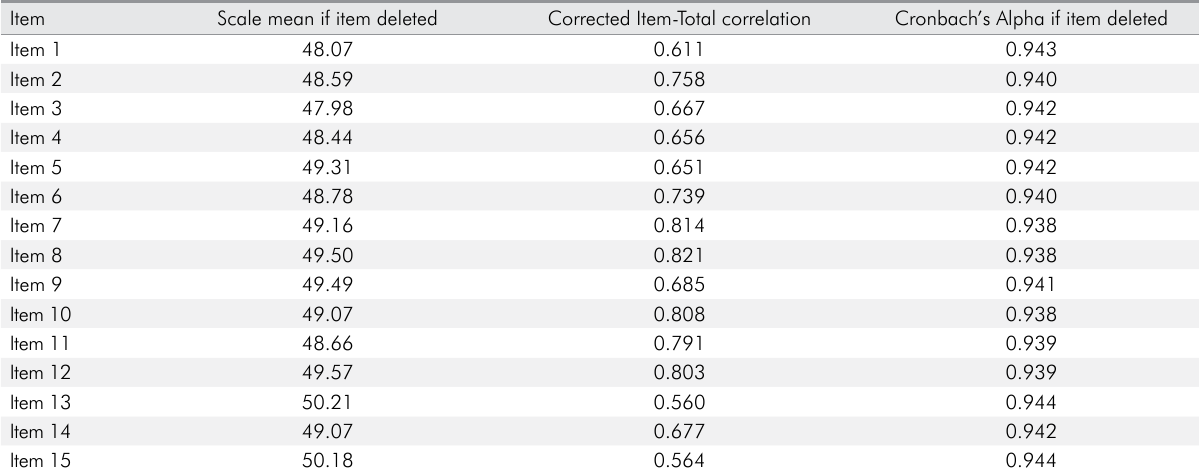
Table 3. Internal consistency of the Brazilian version of DHEQ-15.